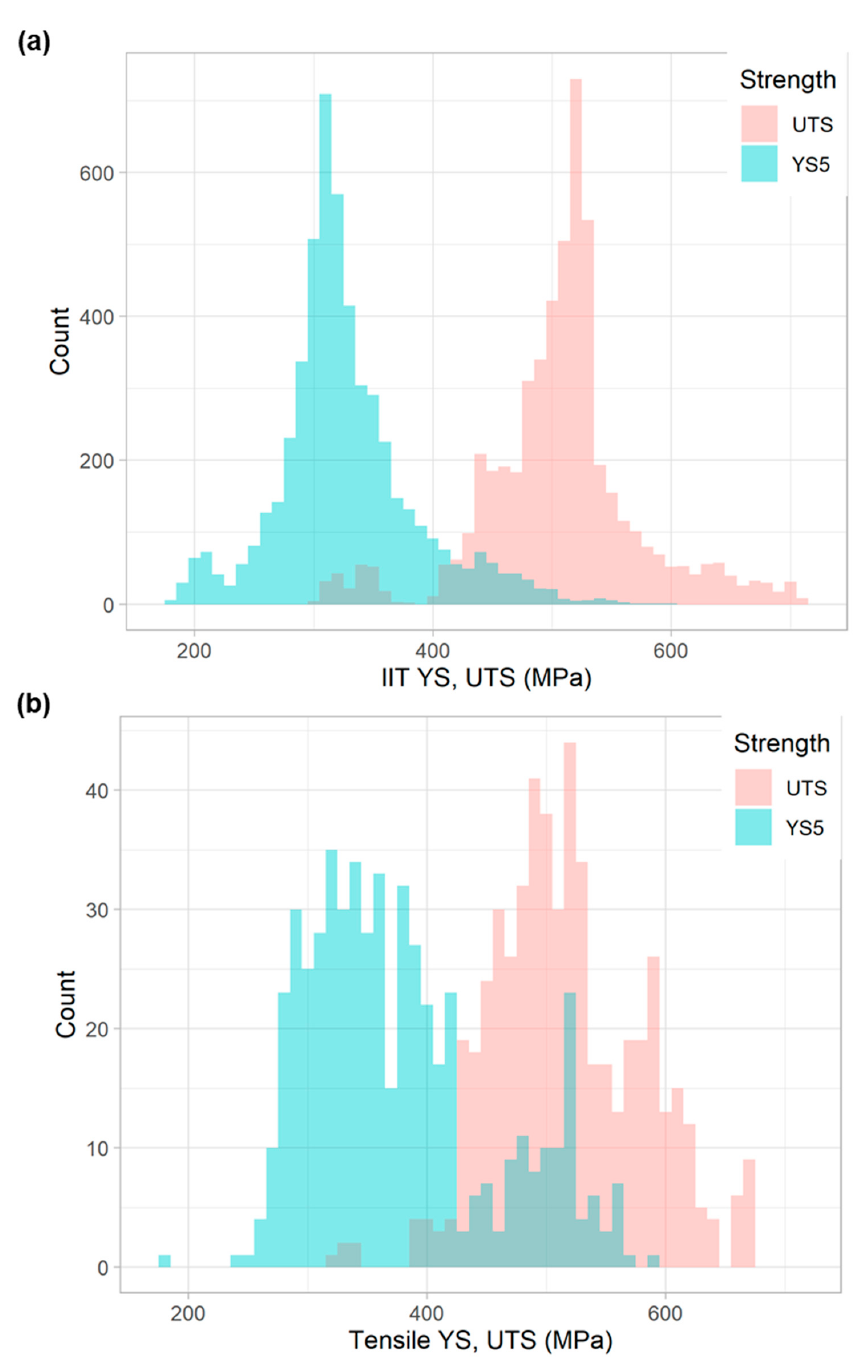
Figure 4. Histogram of YS and UTS for all ( a ) IIT and ( b ) tensile measurements in this study.